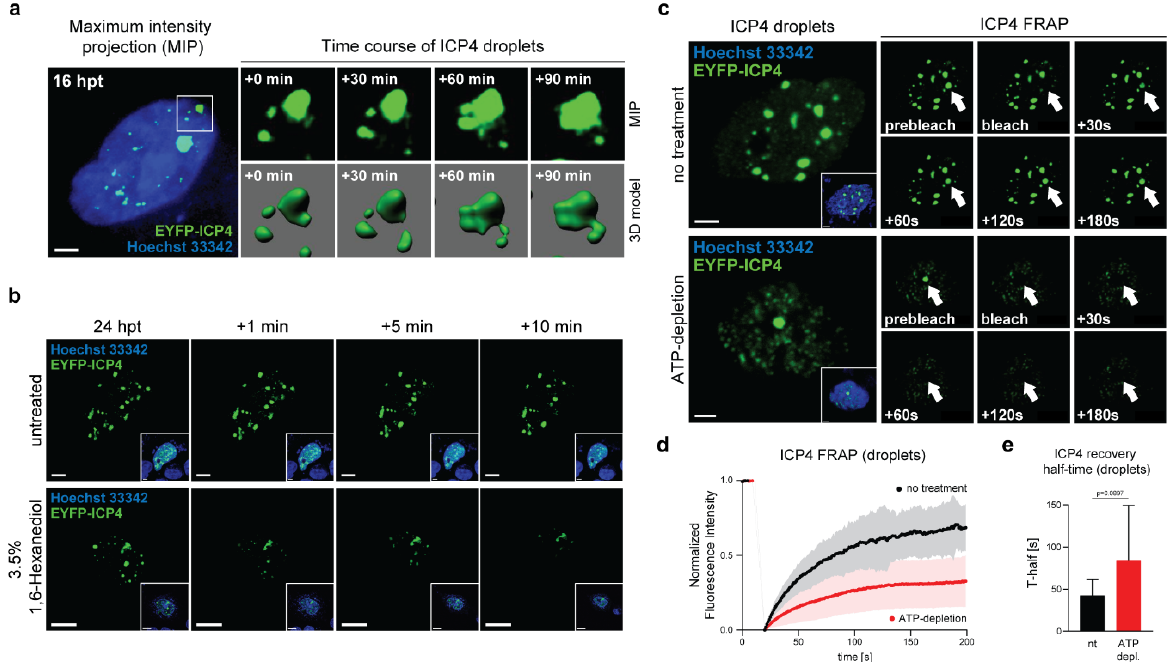
Figure 2. ICP4 condensates have liquid-like properties. ( a ) 3D live-cell imaging of ICP4 condensates. Vero cells were transfected with 0.3 µg of pIE3-EYFPICP4. At 16 hpt, the cells were counterstained with Hoechst 33342 and monitored for 3 h using a spinning disk CLSM (see also Movies S1a,b). A representative cell nucleus displaying ICP4 droplets was selected for 3D modeling using the Imaris software (Bitplane). ICP4 droplet fusion events are indicated in maximum intensity projection (MIP) and rendered 3D images. Scale bar: 10 µm. ( b ) ICP4 condensate integrity is compromised by 1,6-Hexanediol. Vero cells were transfected with 0.15 µg of pIE3-EYFPICP4 and counterstained with Hoechst 33342 at 24 hpt followed by live-cell microscopy using CLSM. The cells were treated with 3.5% 1,6-Hexanediol and fluorescence images were taken at indicated times. Untreated cells were used as a negative control. Scale bars: 10 µm (1,6-Hexanediol) and 3 µm (untreated). ( c ) ICP4 droplets exhibit rapid FRAP kinetics. Vero cells were transfected with 0.15 µg of pIE3-EYFPICP4 and counterstained with Hoechst 33342 at 24 hpt (inset images) followed by FRAP analysis using CLSM. A single ICP4 droplet was bleached (white arrow) and then monitored for 3 min capturing an image every second (see also Movie S2). ATP depletion was performed 2 h before the FRAP experiment (see also Movie S3). Scale bar: 5 µm. ( d ) Quantification and analysis of FRAP experiments. For FRAP analysis, 6–12 individual ICP4 droplets were used. The raw FRAP data were normalized with easyFRAP and analyzed with Prism (GraphPad). The normalized fluorescence intensity is plotted over time (s). ( e ) ICP4 recovery half-times (T-half) were evaluated using the FRAP data from panel (2d) with easyFRAP. Bar plots represent mean values with standard deviations (SDs). Statistical significance was determined using a Welch’s t -test.